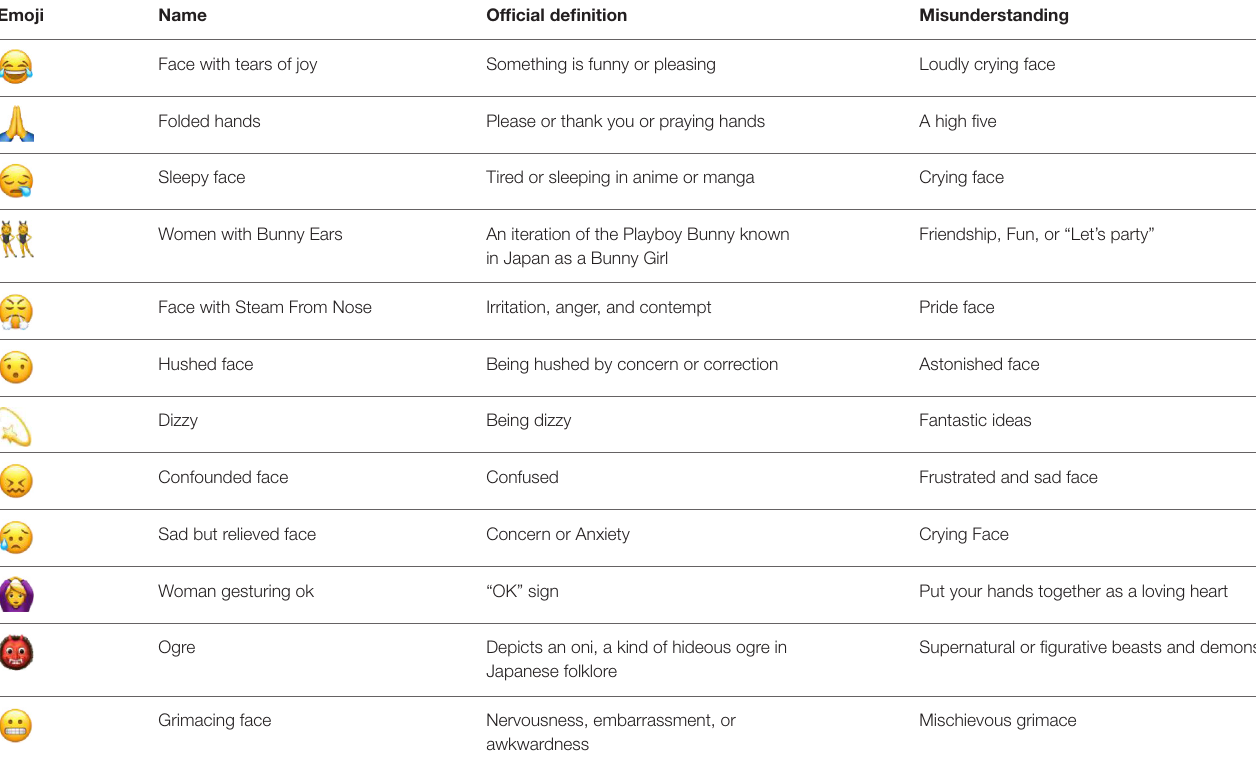
TABLE 5 | Common examples of emoji using ambiguity.